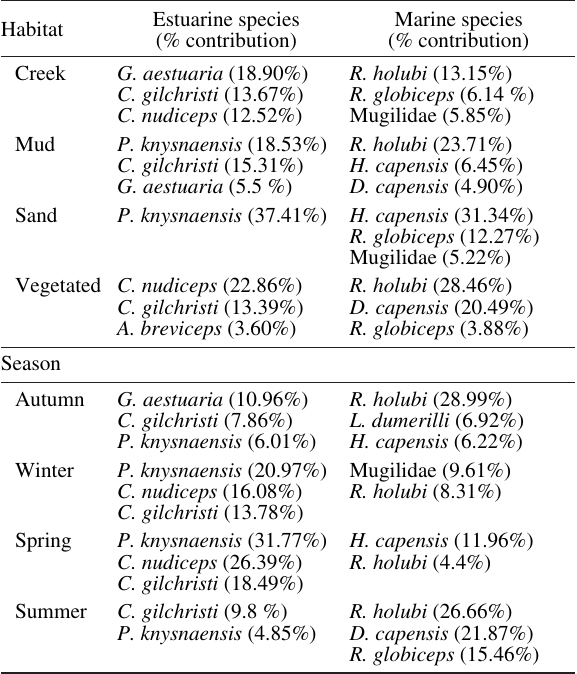
Table 3. – SIMPER test results for each habitat and season. The three species from the estuarine groups (SE and E&M) and marine species groups (MEO, MED, MS) (Potter et al. 2015) that contribute the highest percentages to catch in each habitat. Habitat